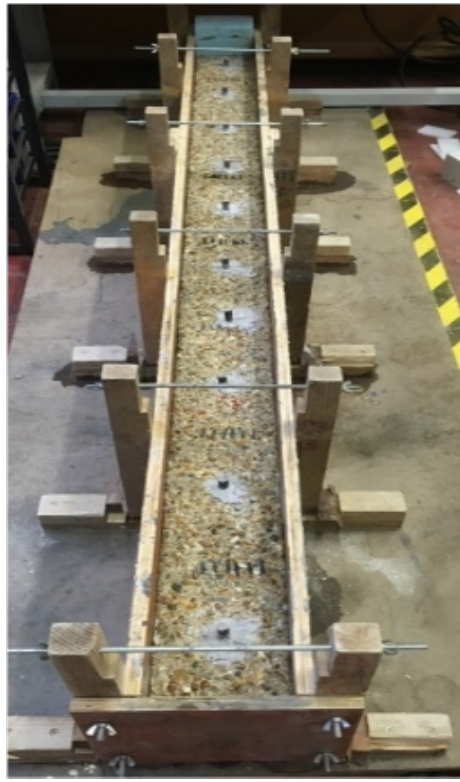
Figure 3. Preparation of the